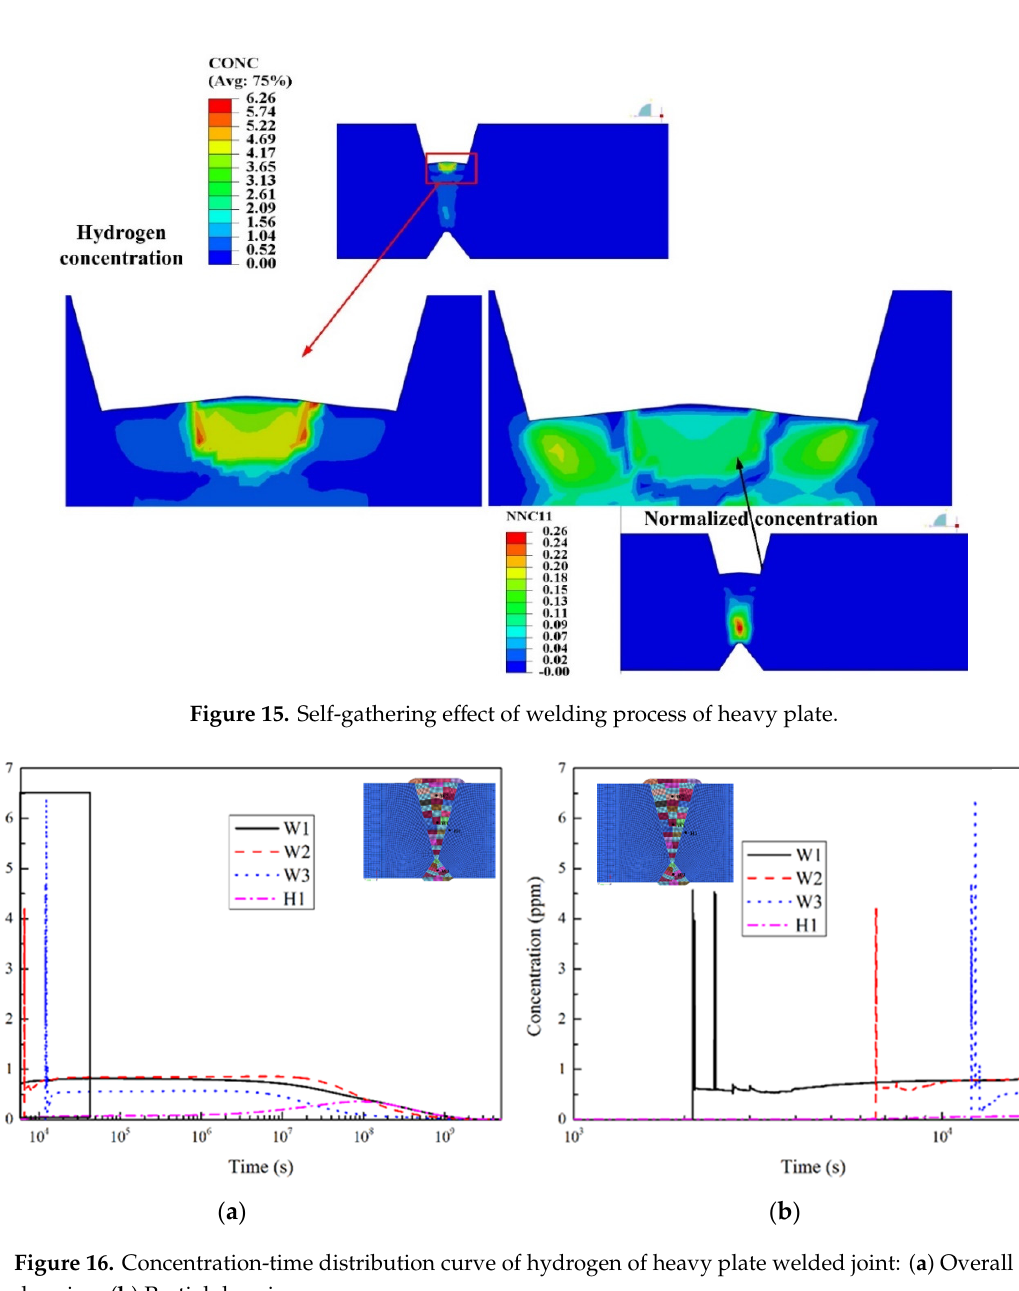
Figure 16. Concentration-time distribution curve of hydrogen of heavy plate welded joint: ( a ) Overall drawing; ( b ) Partial drawing.